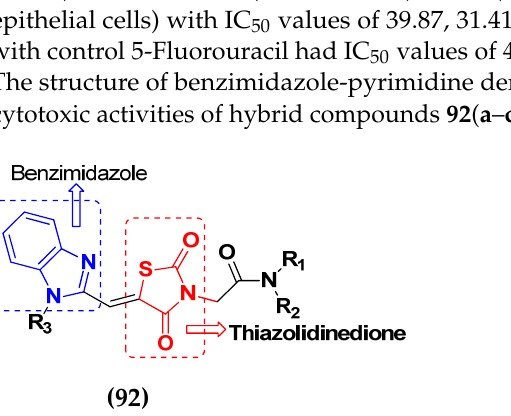
Figure 89. Structure of benzimidazole–thiazolidinedione derivatives ( 92 ).